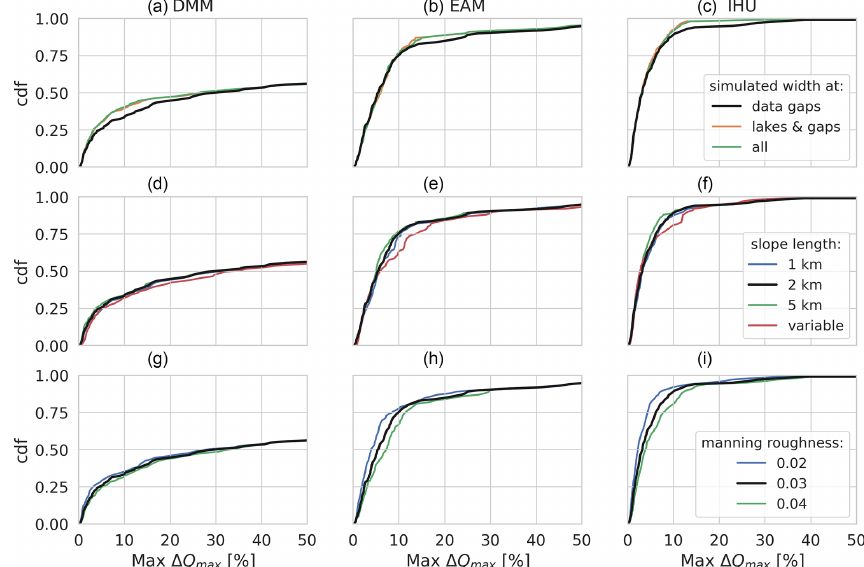
Figure F1. Sensitivity analysis of the relative difference in simulated peak magnitude for a case study in the Rhine basin for three parameters (rows) and for three upscaling methods (columns). Each plot shows the CDF of all output locations on the y axis and the relative difference in simulated peak magnitude on the x axis. The first row shows the sensitivity to the average MERIT Hydro vs. power-law-based channel width estimates; the second row shows the sensitivity to the minimum channel length over which the channel slope is estimated, and the third row shows the sensitivity to the Manning roughness coefficient. The black line is the default case in all